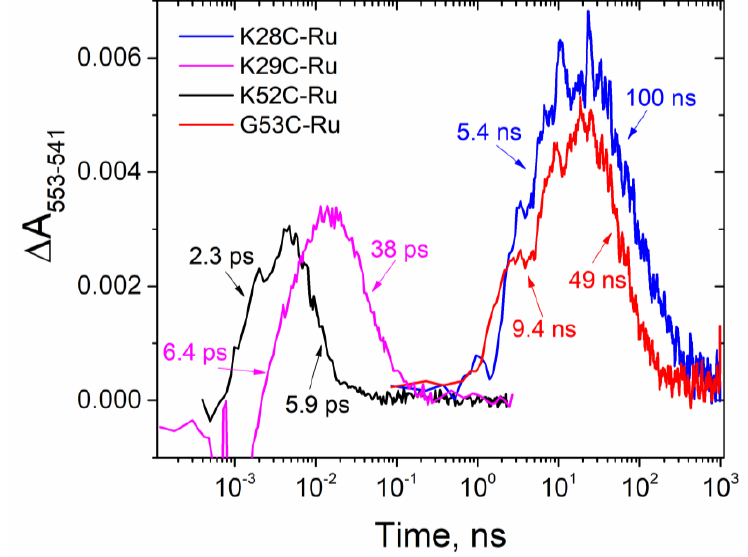
Figure 3. Kinetics of photo-induced electron transfer in biohybrids.